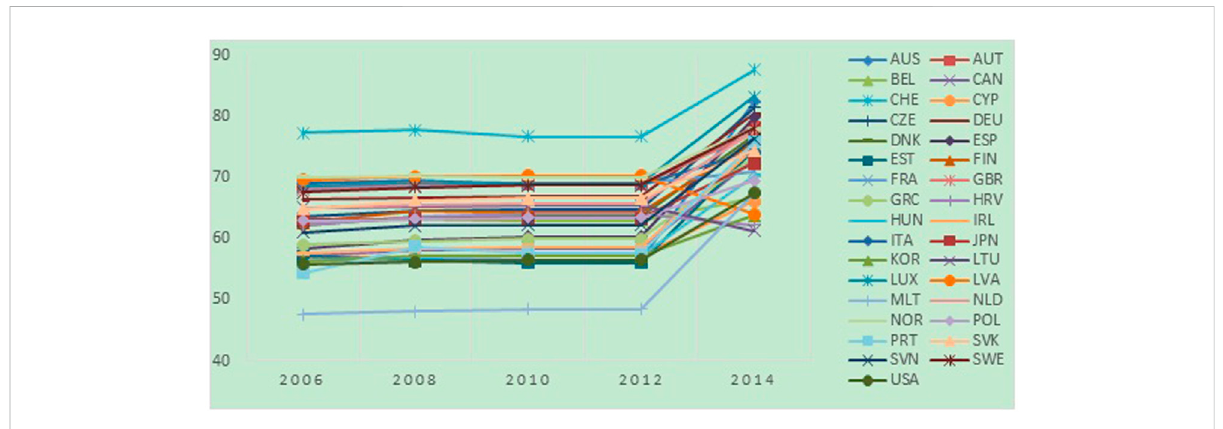
FIGURE 1 Trend of the EPI in high-income countries.